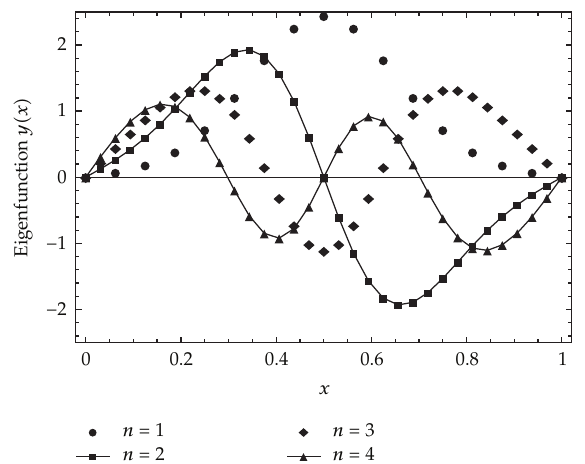
Figure 1: Higher eigenfunctions of Mathieu’s equation for a fixed parameter θ (cid:5) 5.